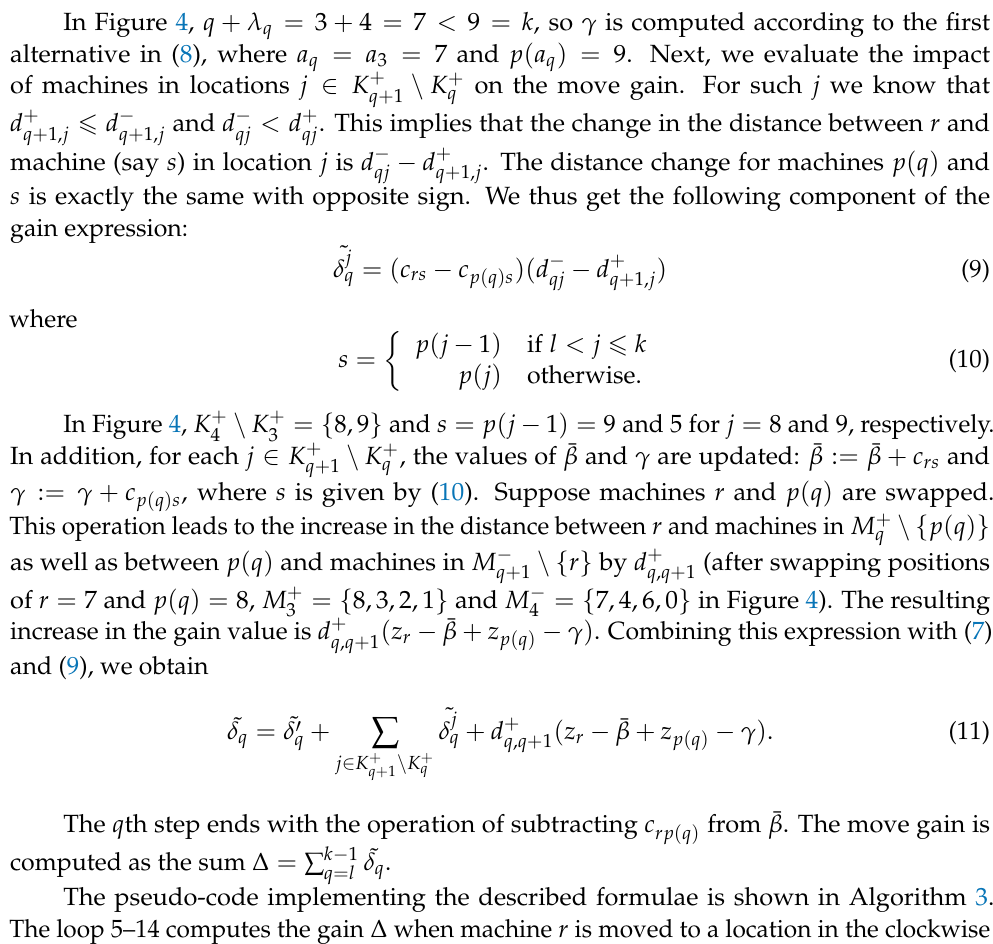
Figure 4. Moving machine r = 7 counterclockwise from location k = 9 to location l ∈ { 1,2,3 } : ( a ) initial solution; ( b ) solution at the q th step where q =